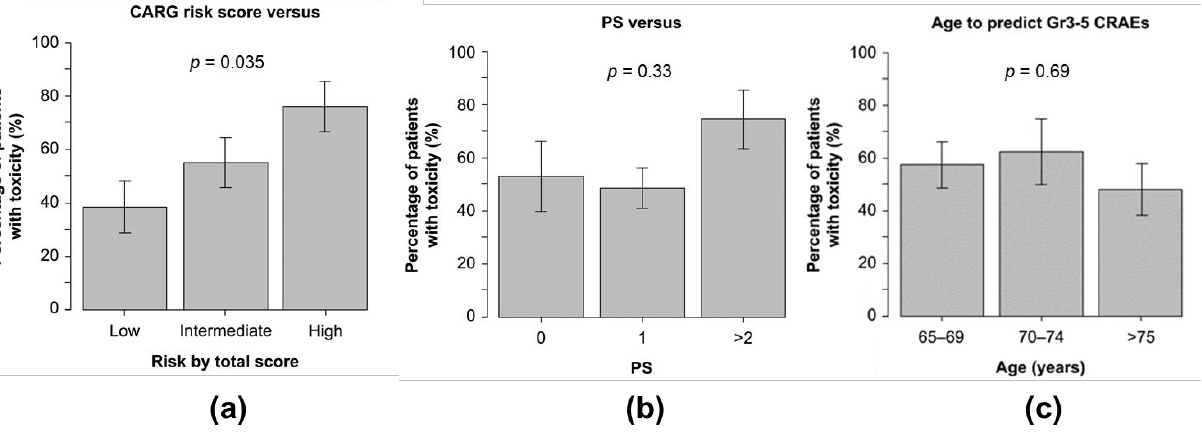
Figure 1. Ability of ( a ) CARG risk score vs. ( b ) ECOG PS vs. ( c ) age to predict grade 3–5 CRAEs. Abbreviations: CARG, Cancer and Aging Research Group; CRAEs, chemotherapy-related adverse events; ECOG PS, Eastern Cooperative Oncology Group performance